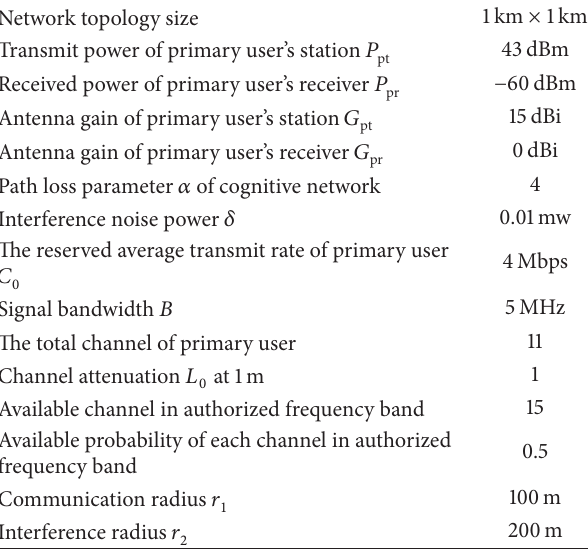
Table 1: Main parameters of numerical